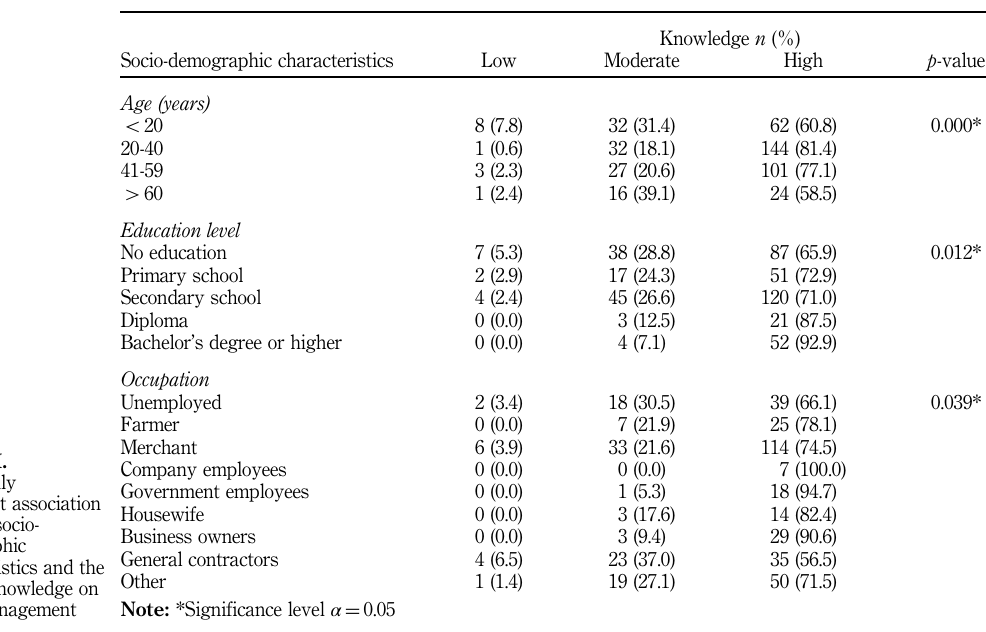
significant association between socio- demographic characteristics and the level of knowledge on MSW